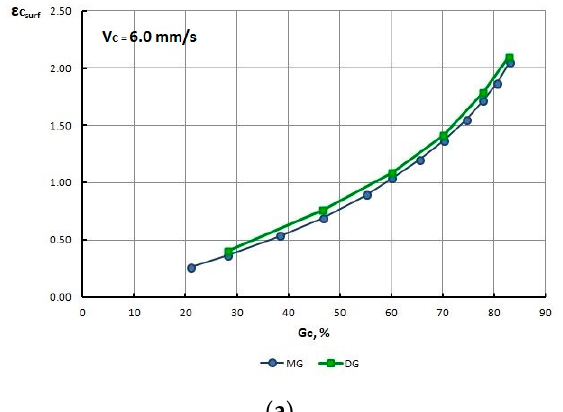
Figure 13. Change of strain level on the surface ε c surf , axis ε c axis and non-dilatational strain in wires drawn with low ( a ) and high ( b ) single section reductions, at a drawing speed of V c = 6.0 m/s, as a total drawing reduction